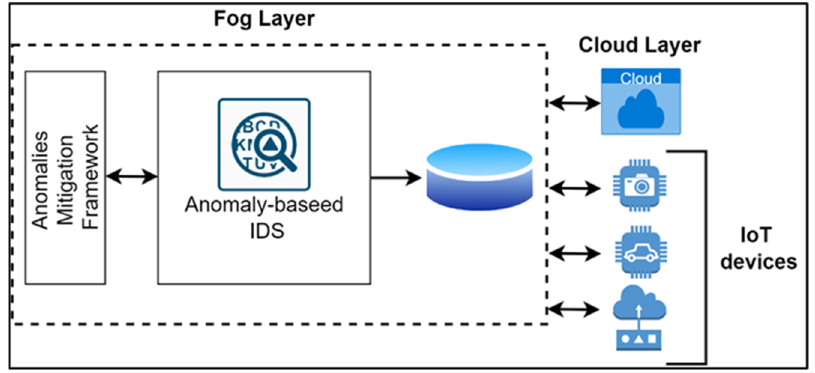
Figure 10. Proposed fog framework.